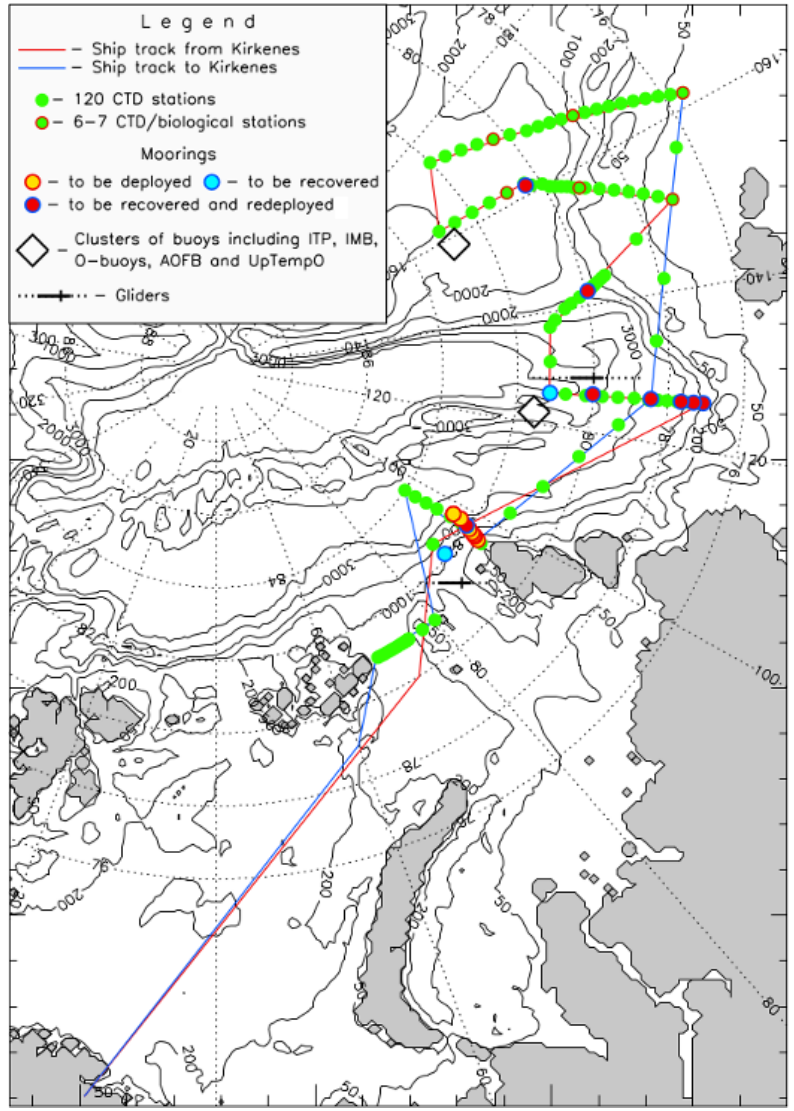
Figure 5. Oceanographic observations carried out during the Nansen and Amundsen Basins Observational System (NABOS) cruise in summer 2015, including CTD profiles, biological stations, deployment and recovery of moorings, and deployment of buoys and gliders. Source: http://research.iarc.uaf.edu/NABOS2/cruise/2015/ (last access: 23 January 2019). Reproduced with permission from Igor Polyakov, the University of Alaska